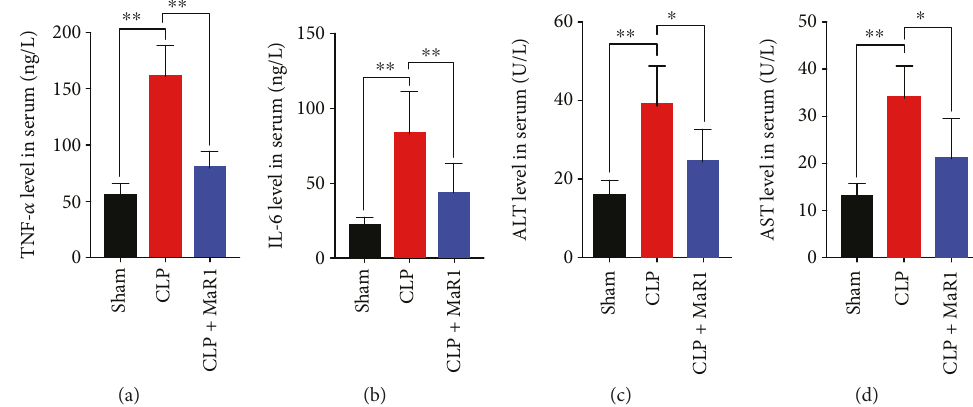
Figure 3: MaR1 reduced TNF- α , IL-6, and ALT/AST levels in CLP-induced septic mice. Blood samples were collected after CLP surgery at 24h time point and then centrifuged at 3000g for 10 min to collect serum. (a, b) The serum levels of TNF – α and IL-6 were, respectively, determined using ELISA kits. (c, d) Then, the levels of alanine aminotransferase (ALT) and aspartate aminotransferase (AST) in blood were determined by biochemistry assay kits. Data are presented as mean ± SD . ∗ P < 0 05 and ∗∗ P < 0 01 , n = 5 per group.